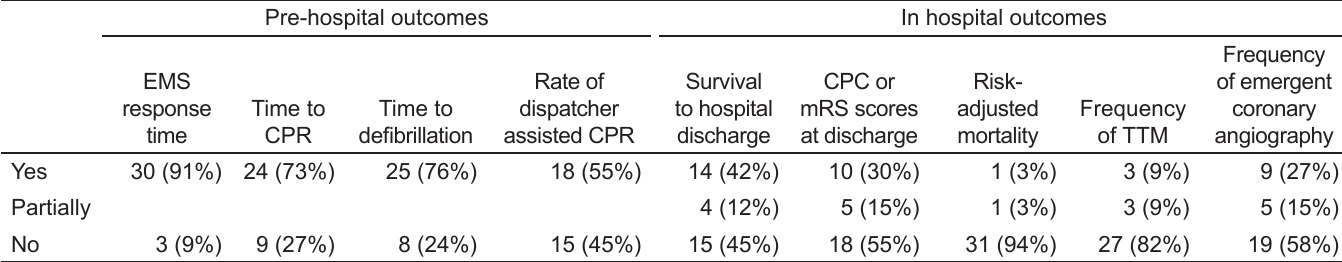
Table 2. Number of California local EMS Agencies (LEMSA) that track and maintain quality improvement processes and outcomes in cardiac-arrest care